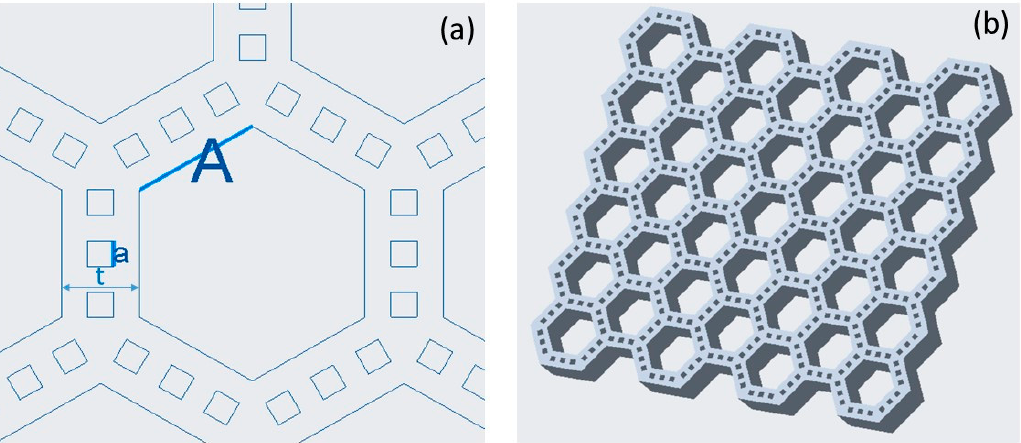
Figure 1. ( a ) A characteristic unit cell with labeled key design parameters and ( b ) a bamboo-like test structure without the flat plates at the top and the